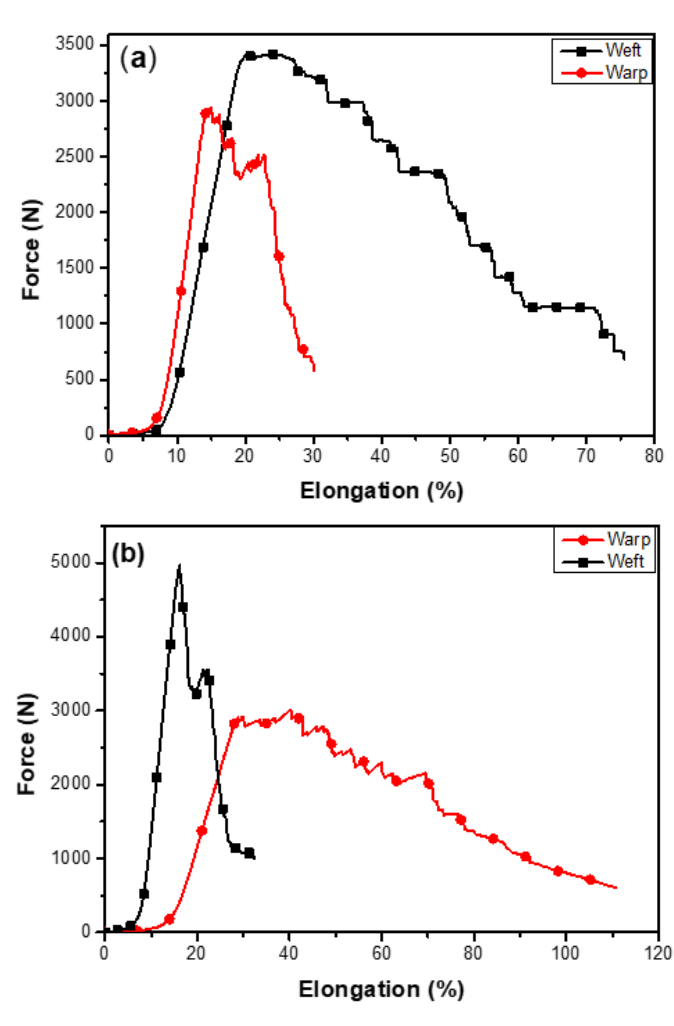
Figure 5. Comparison of tensile properties of auxetic woven fabric. ( a ) Matt weft and warp, and ( b ) twill weft and warp.